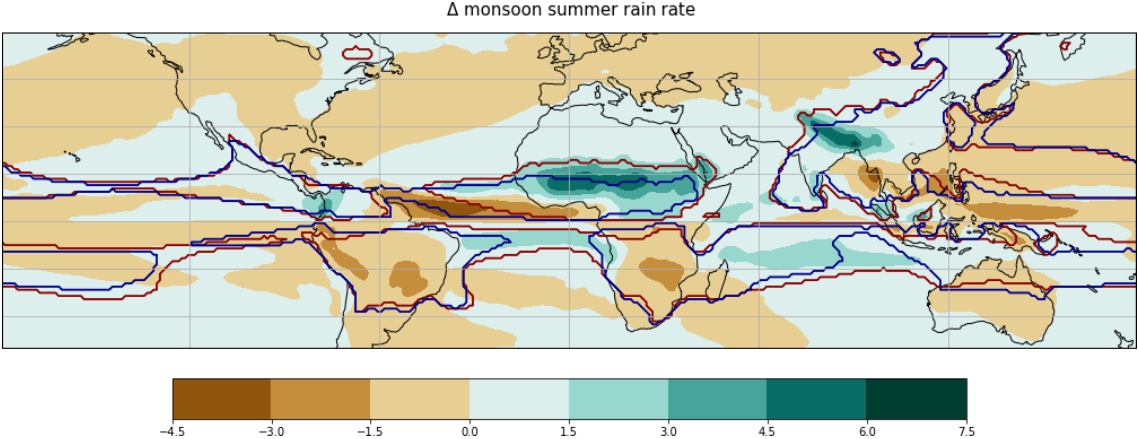
Figure 9. Ensemble-averaged Last Interglacial change in monsoon-related rainfall rate (in mmd − 1 ). Red and blue contours show the bound- aries of lig127k and piControl monsoon domains, respectively, using the definitions of Wang et al.